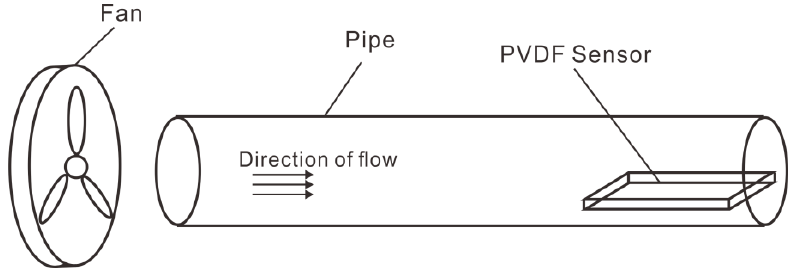
Figure 11. Position of PVDF sensor.